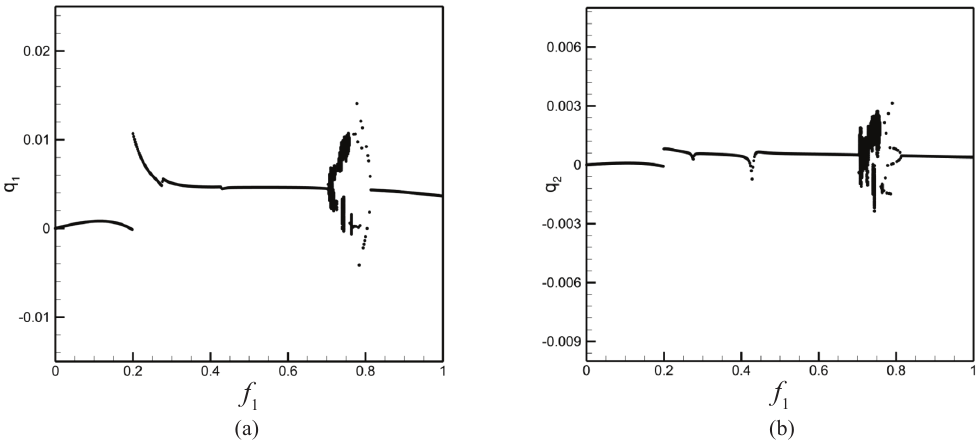
Fig. 7. Bifurcation diagrams of Poincaré points for increasing forcing amplitude on the system with c = 0 . 2 ,α = 5 and β = 1 .